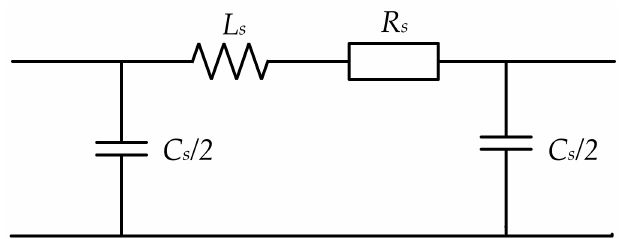
Figure 3. π -type concentrated parameter equivalent circuit